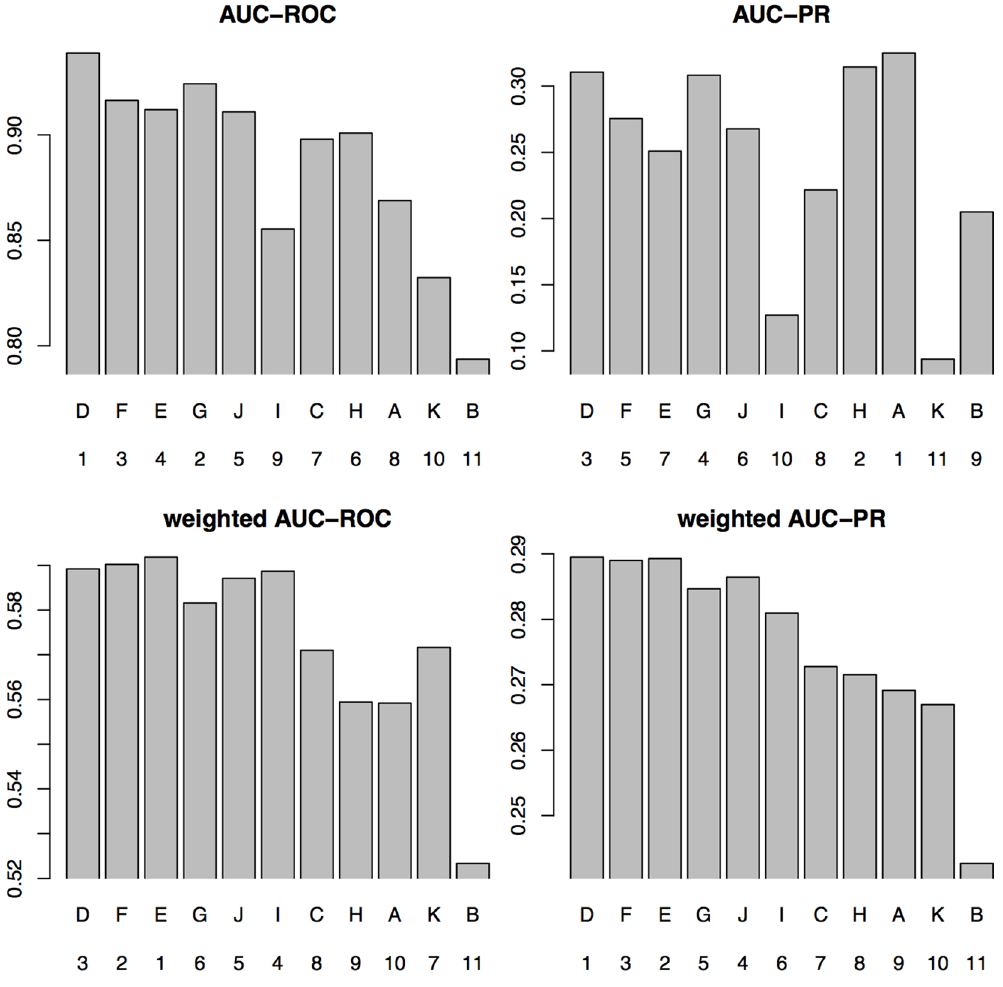
Figure 6. Mean results for AUC-ROC and AUC-PR on PBM data sets using unweighted or weighted test data. The team name and the ranking is depicted on the abscissa, while the mean result for AUC-ROC and AUC-PR is depicted on the ordinate. Teams are displayed in the order of the original ranking of Weirauch et al. [27].